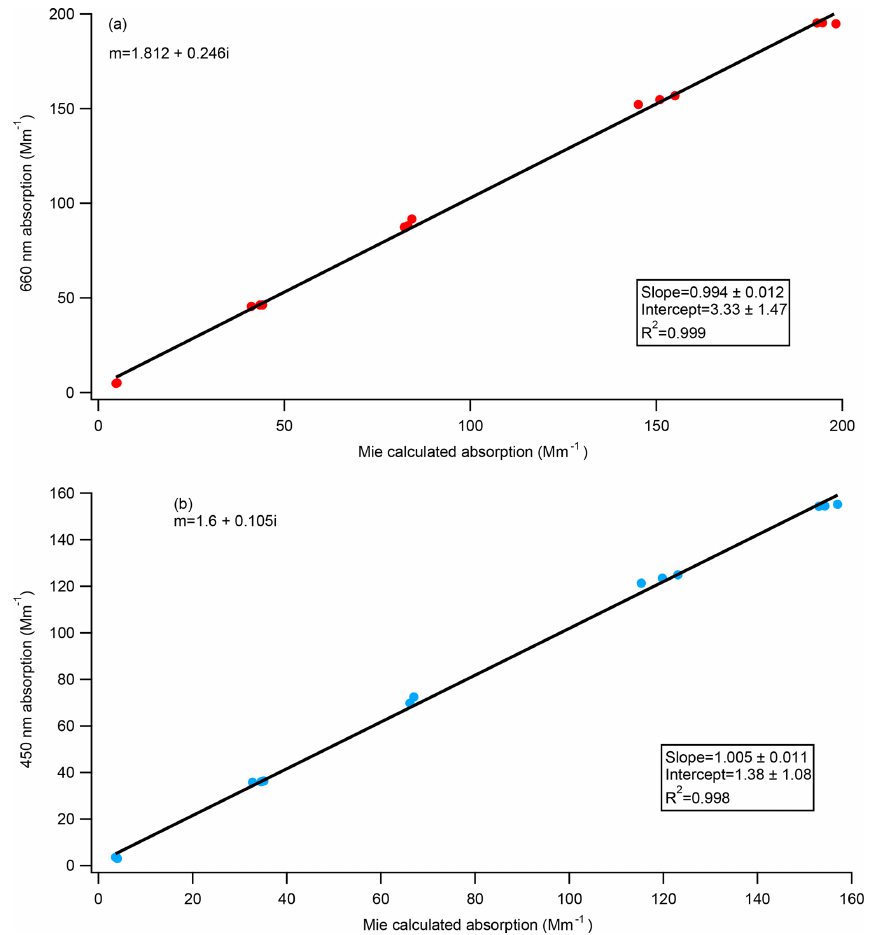
Figure 7. Absorption from CAPS PM SSA data versus calculated absorption from SMPS size distributions, using Mie theory and the refractive indices as shown in figure. Panel (a) is for the 660nm instrument while panel (b) is from the